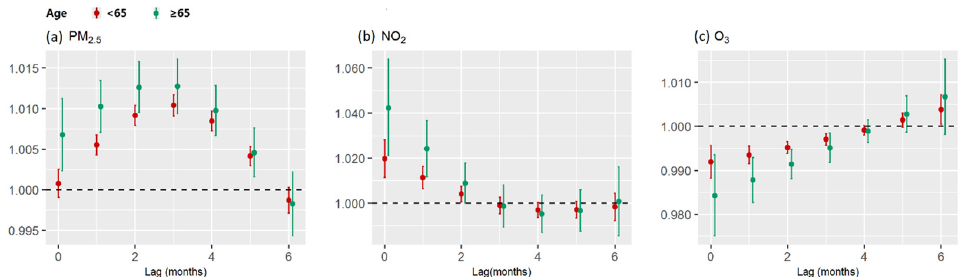
Figure 5. Lag-specific relative risks (95% confidence interval (CI)) of pulmonary tuberculosis (PTB) by age group for 10-unit increases in the mean monthly concentrations of air pollutants based on single-pollutant models. ( a ) Air pollutant: PM 2.5 . ( b ) Air pollutant: NO 2 . ( c ) Air pollutant: O 3 .